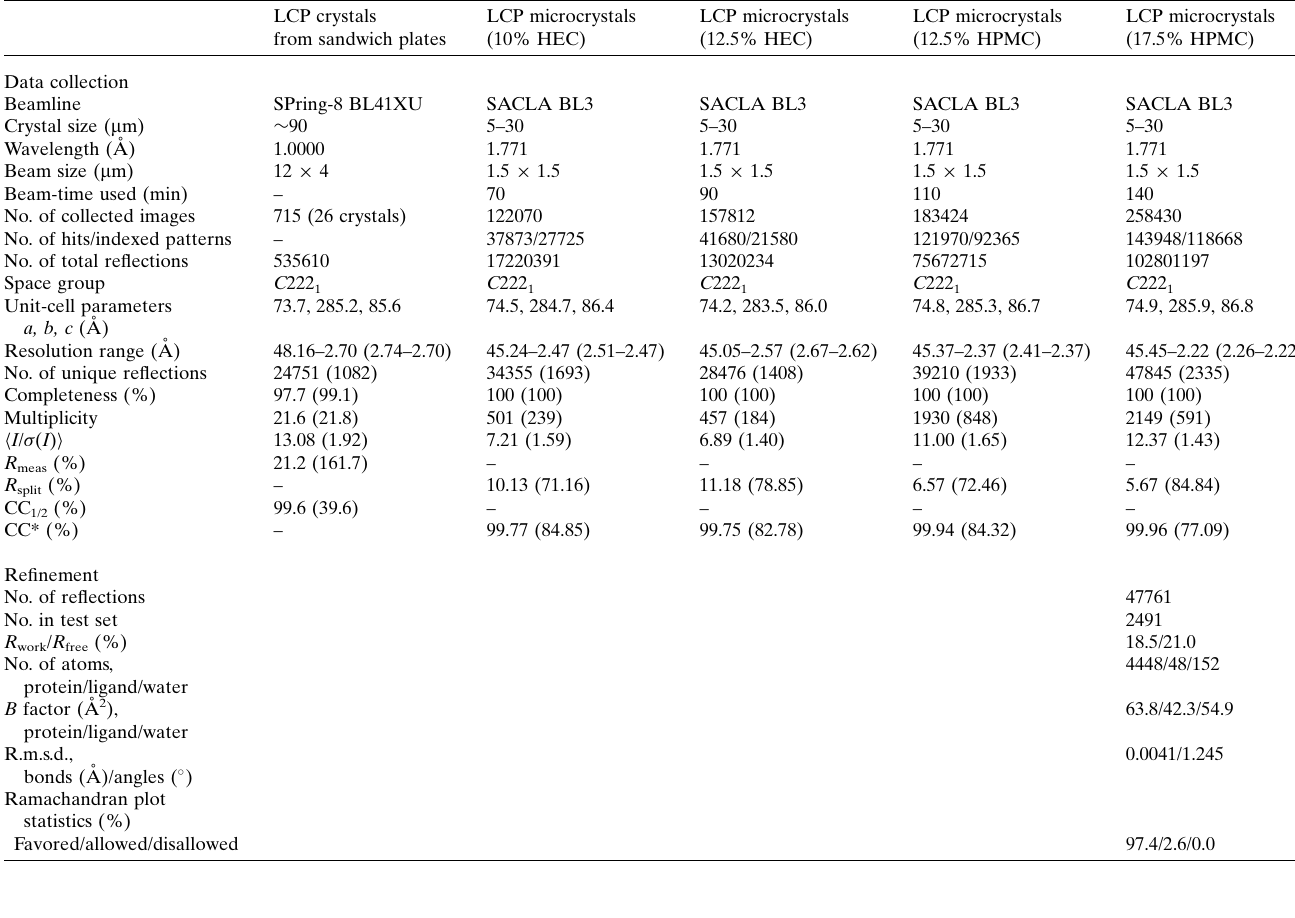
Table 2 Data-collection and refinement statistics. Values in parentheses are for the highest-resolution